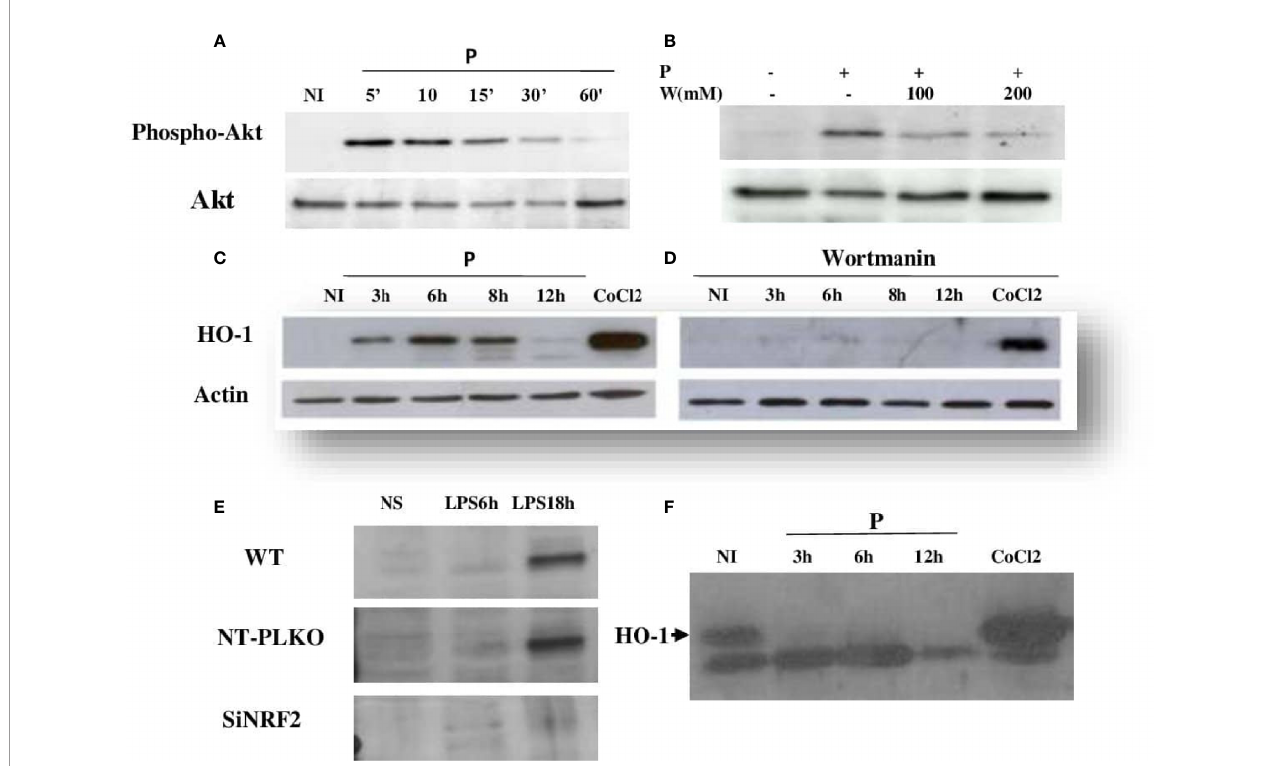
FIGURE 3 | Leishmania major induced HO-1 expression through PI3K/Akt and the Nrf2 transcription factor. (A, C) Raw264.7 cells were infected for the indicated time periods with L. major promastigotes and the expressions of Akt and HO-1 assessed using Western blot. CoCl 2 stimulation for 3 h (250 ng/ml) was used as the control. (B, D) Macrophages were pre-incubated with wortmannin (200 mM) for 3 h, followed by infection with L. major promastigotes for different times. Akt phosphorylation and HO-1 expression were determined by immunoblotting. (E) Raw264.7 cells were transfected (24 h) with either Nrf2 (Si) or control siRNA (NT- pLKO), followed by infection with lipopolysaccharide (LPS) for 18 h, lysed, and examined by Western blot for Nrf2 expression. (F) NRF2 − / − cells were infected for different times with L . major promastigotes, lysed, and examined by Western blot for HO-1